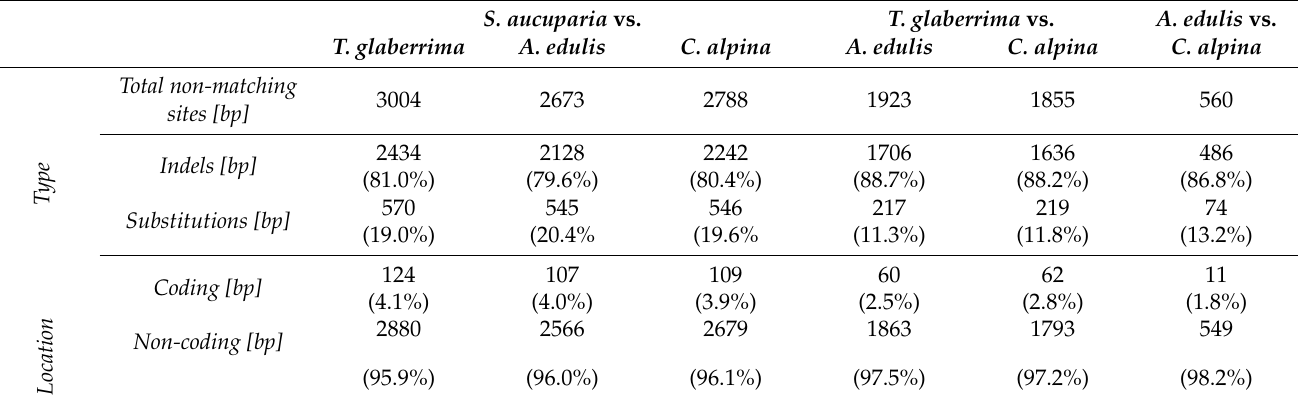
Table 1. General statistics of non-matching nucleotides in the pairwise alignments of chloroplast genome assemblies of S. aucuparia, T. glaberrima, A. edulis and C. alpina . S. aucuparia